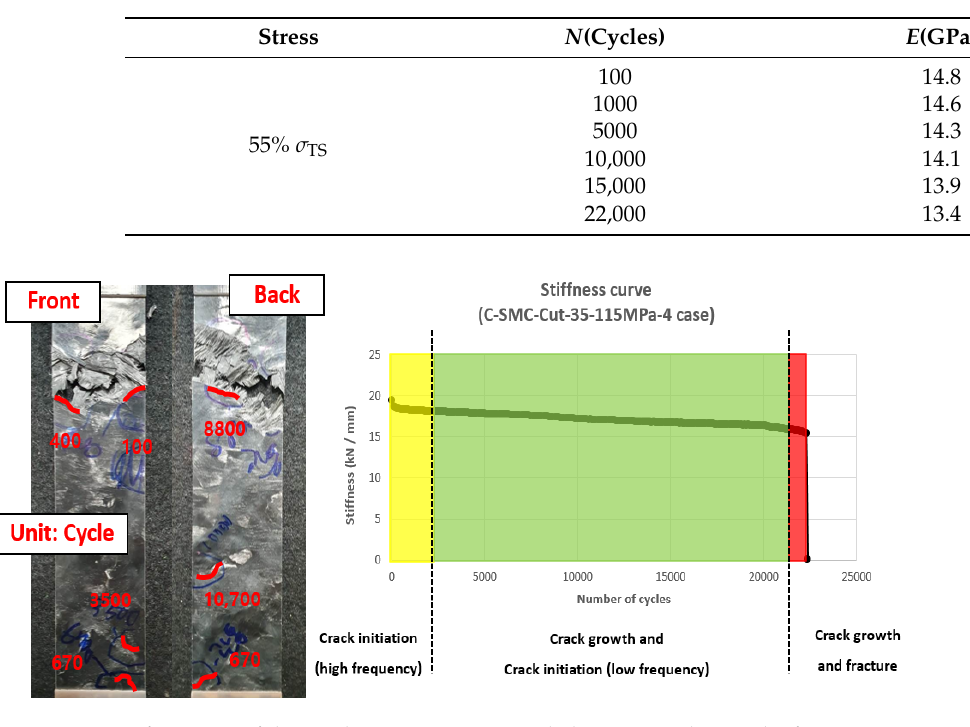
Figure 18. Confirmation of the crack initiation via visual observation during the fatigue test.